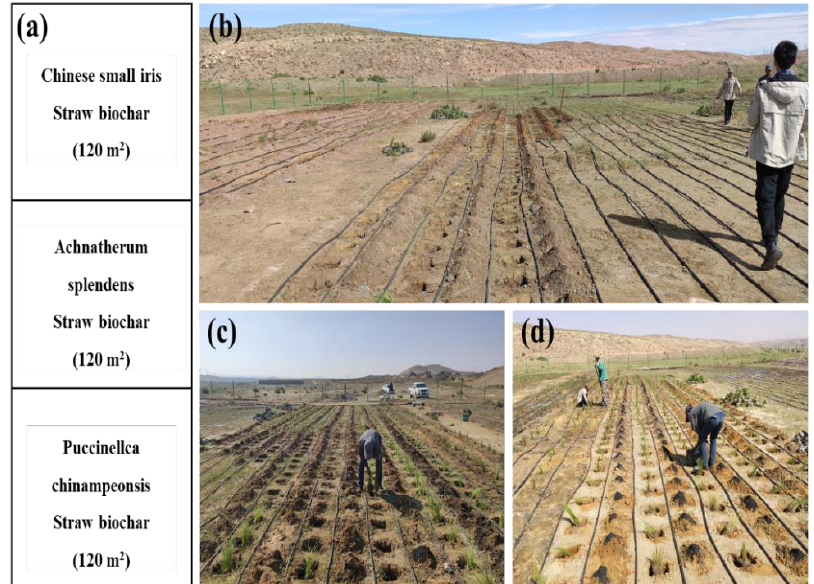
Figure 4. Coupled stabilization zone: ( a ) plot of the complex stabilization zone, ( b ) planting holes excavating, ( c ) mixing of biochar and soil, and ( d ) seedling planting and soil backfilling.